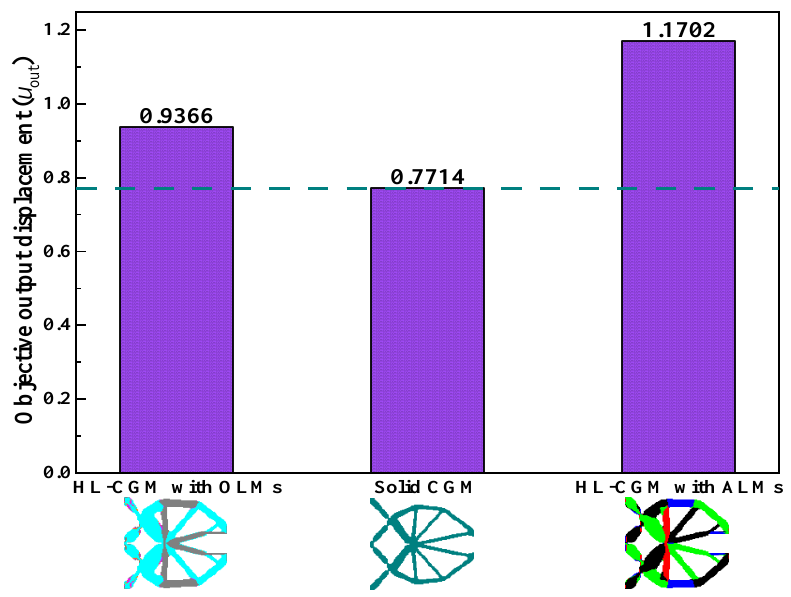
Figure 15. Objective output displacement comparison of different CGMs.